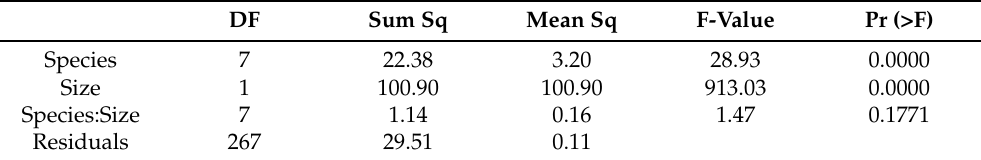
Table A1. ANOVA of a linear model ln ( M a ) i = β 0 + β 1 × Species ln ( Size ) i + (cid:101) i .